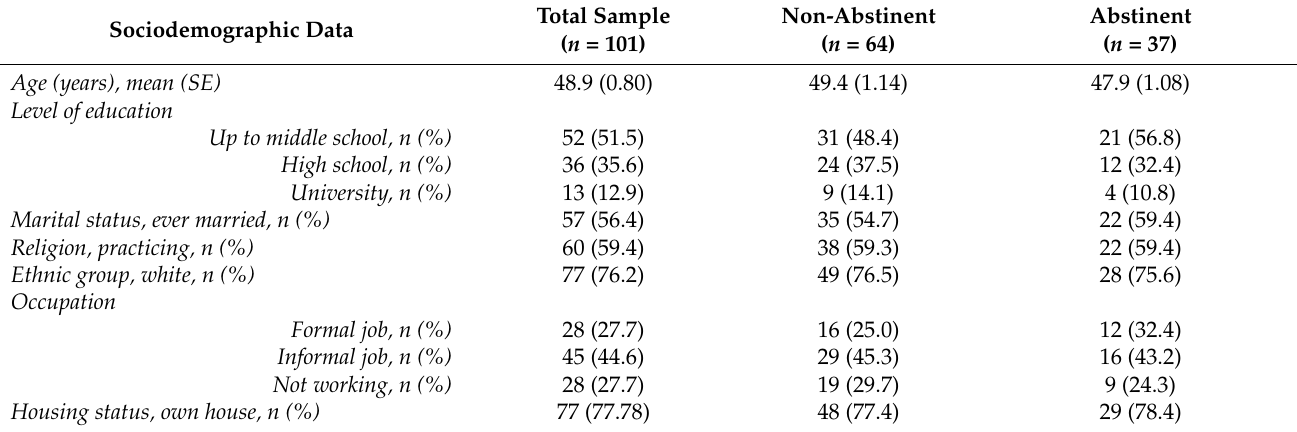
Table 2. Sociodemographic data of the sample (after a 12-week naltrexone treatment). Sociodemographic Data